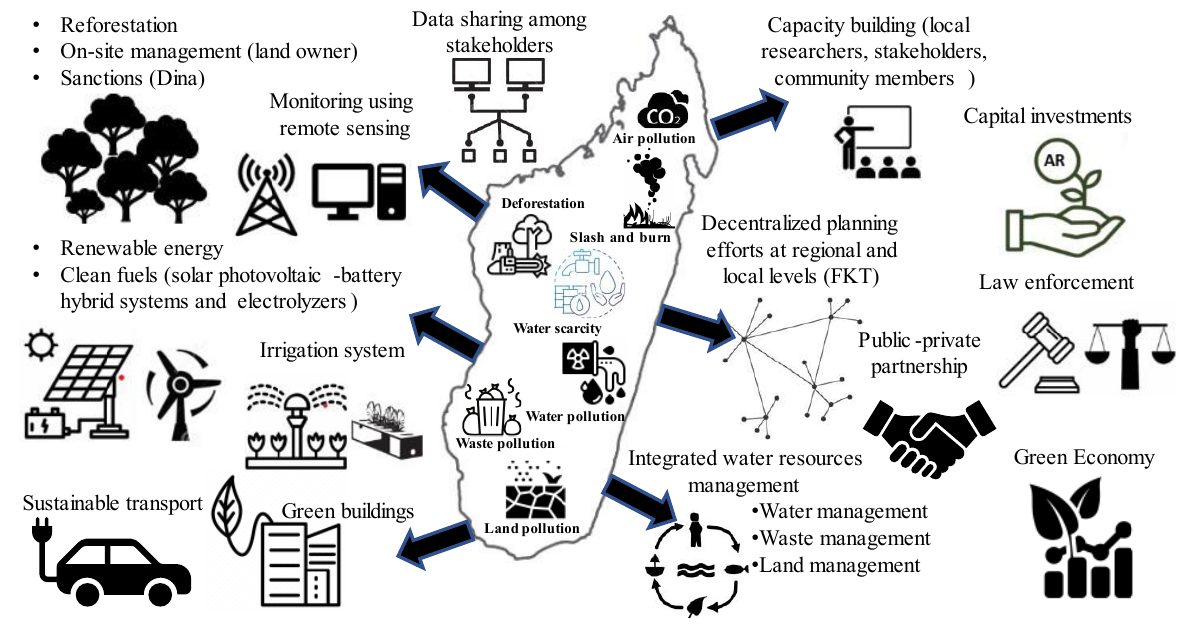
Figure 7. Strategies for solving Madagascar’s environmental problems and achieving the SDGs (Source: Authors).